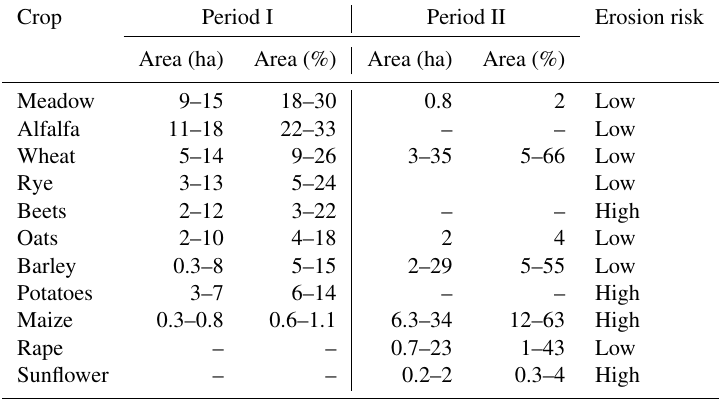
Table 2. Crop statistics of arable land for periods I and II: Period I represents crop statistics for the years 1946–1949, and Period II represents crop statistics for the years 2007–2012. The erosion risk for a particular crop is classified as high or low according to the classification of management using the RUSLE. The statistical values represent the ranges of the area for each crop during periods I or II.